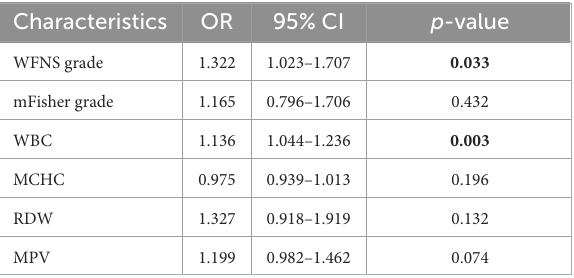
TABLE 2 Multivariate logistic regression of baseline characteristics and admission CBC parameters associated with poor functional outcome at 3